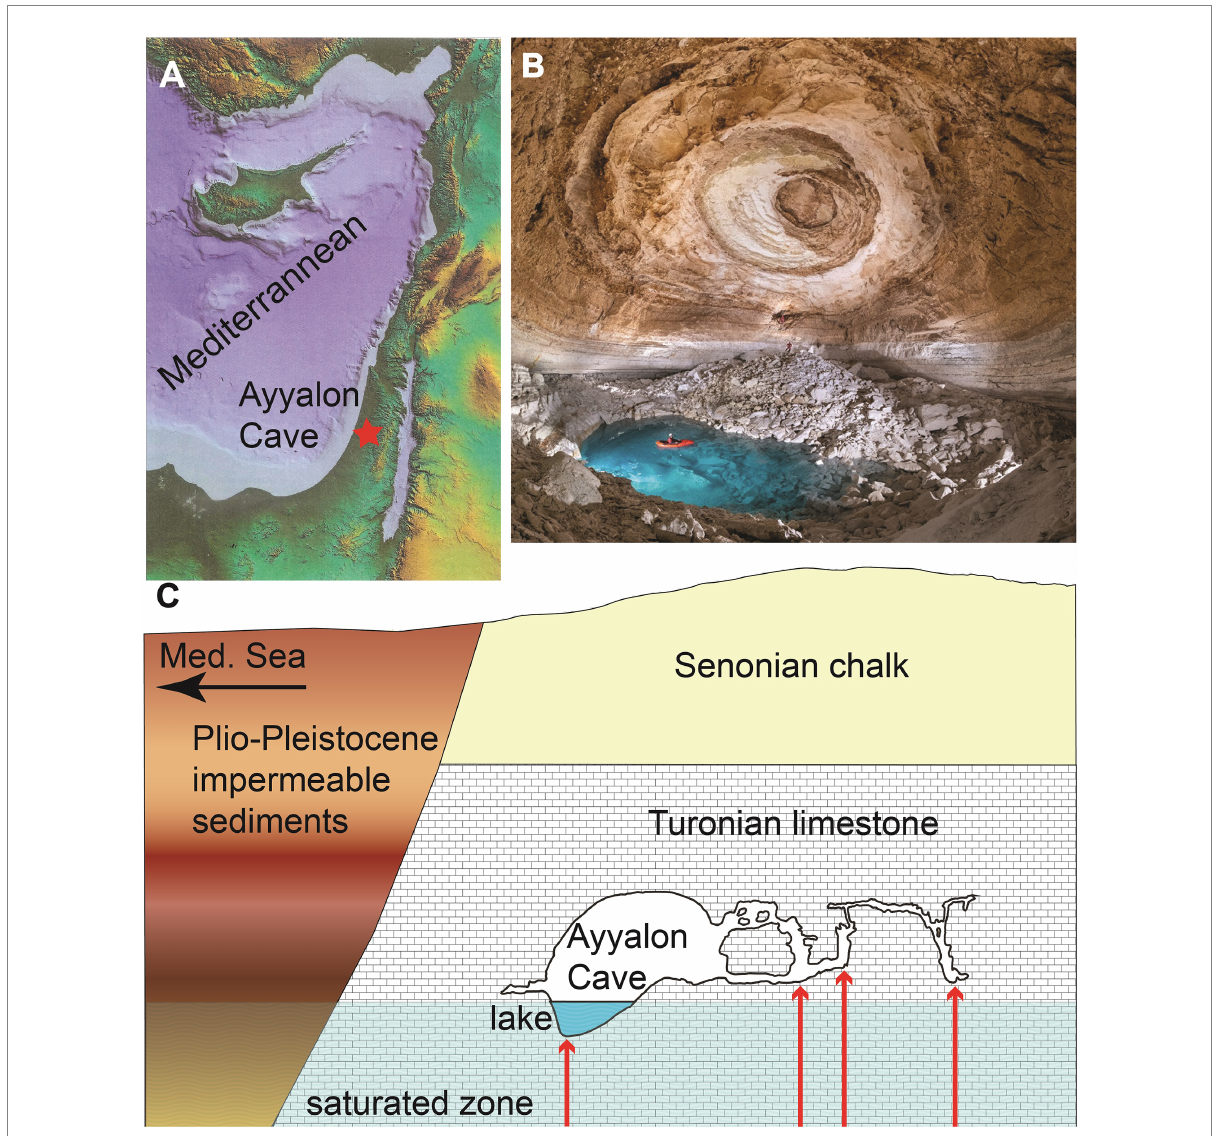
FIGURE 1 Ayyalon Cave configuration. (A) location; (B) the main chamber and groundwater pond of the cave, acting as the ecosystem focal point (photo: Boaz Langford); (C) schematic geological cross section of the cave and associated hydrogeology. For location of section see blue indicators in Figure